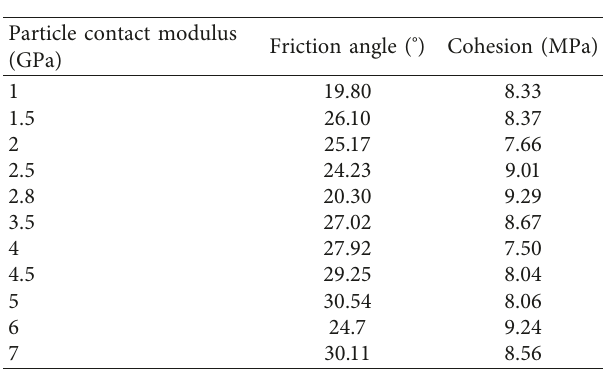
Table 3: Shear strength parameter values under different particle contact moduli.